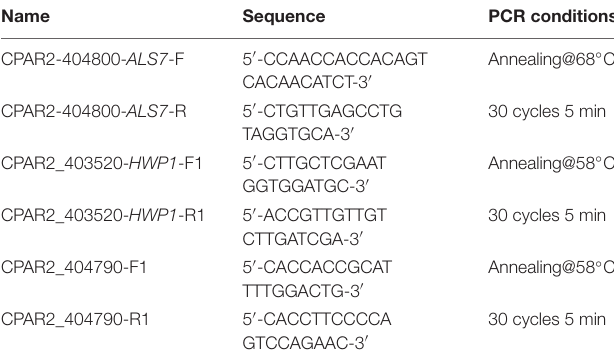
TABLE 3 | oligonucleotides and conditions used for PCR